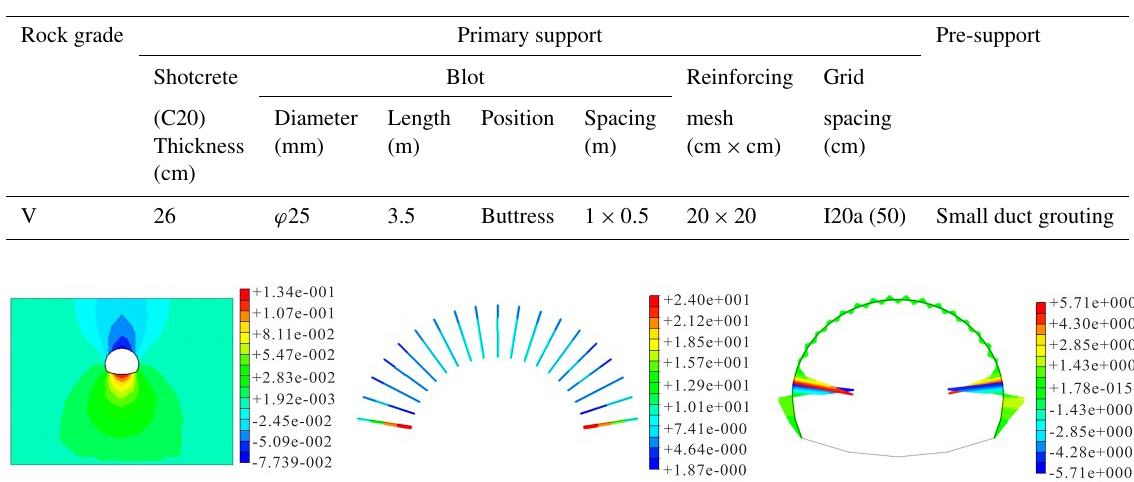
Table 4. Design parameters of the primary support.